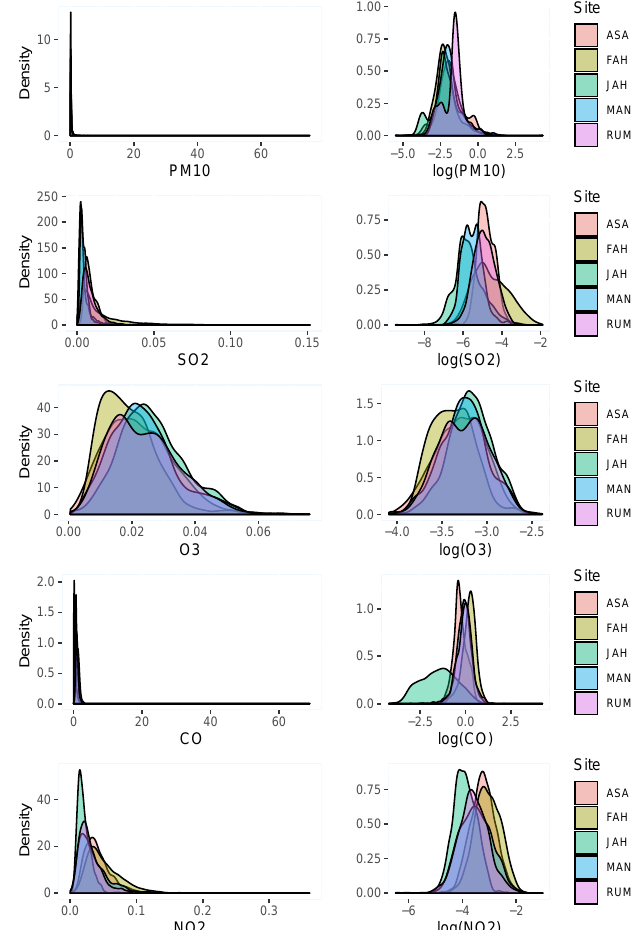
Figure A4. Distribution analysis for PM 10 , SO 2 , O 3 , CO , and NO 2 during 2012 to 2017, according to site location in the State of Kuwait. It is very obvious that log transformation fixes the distribution shape for all pollutants. This step is very important—that is, normalizing the skewed data, such that they approximately conform to normality—in order to use them in the imputational calculation for more accurate results